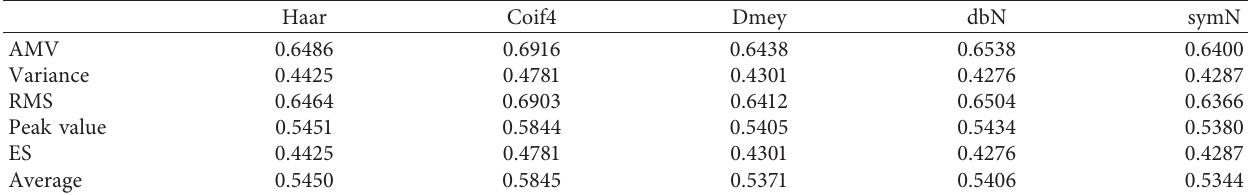
Figure 9: Diagram of consistency indicator value for six characteristic parameters. Table 2: Table of trend values for different characteristic parameters decomposed by different wavelet